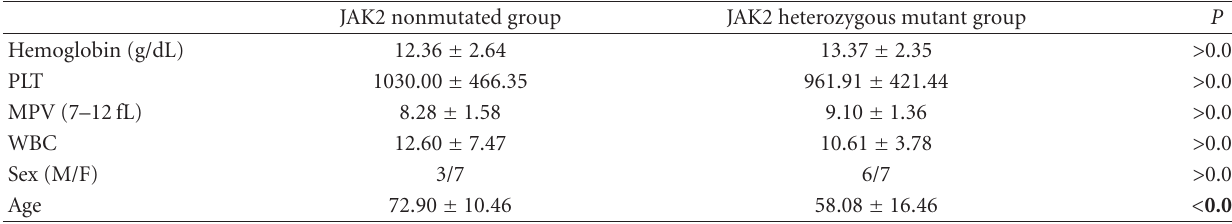
Table 4: Comparison of laboratory tests in ET group.